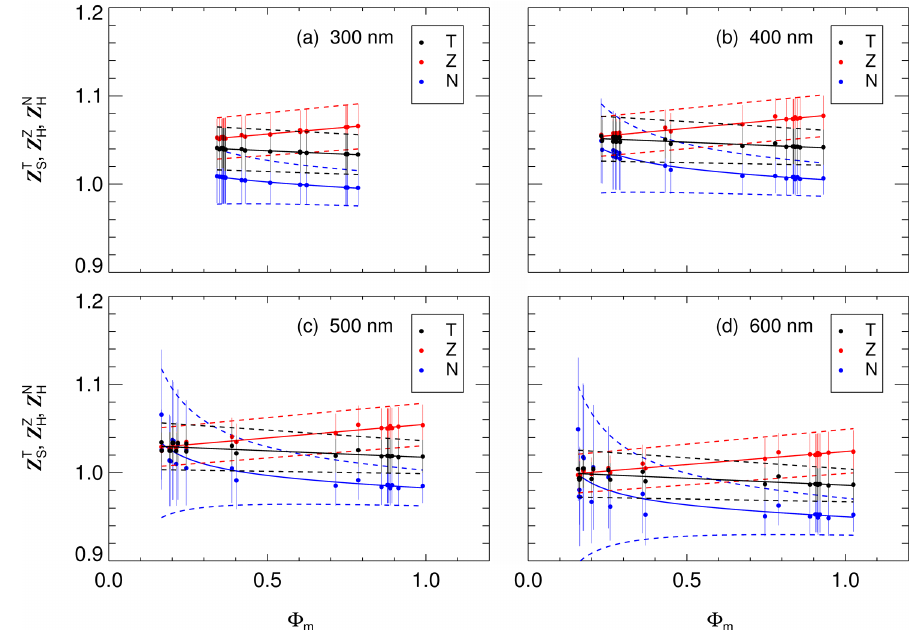
Figure 14. Correction functions Z T (N) for HALO at an altitude of 5km, a solar zenith angle of 40 ◦ and selected (T), Z Z (Z) and Z N H H S wavelengths in panels (a) – (d) as a function of (cid:56) m (ratio of uncorrected upward/downward spectral actinic flux densities). Data points with error bars show the results for all relevant atmospheric scenarios (Table S1) for a solar heading angle γ ◦ = 90 ◦ of the FLT configuration. Full lines are parametrizations, with estimated uncertainty ranges indicated by the dashed